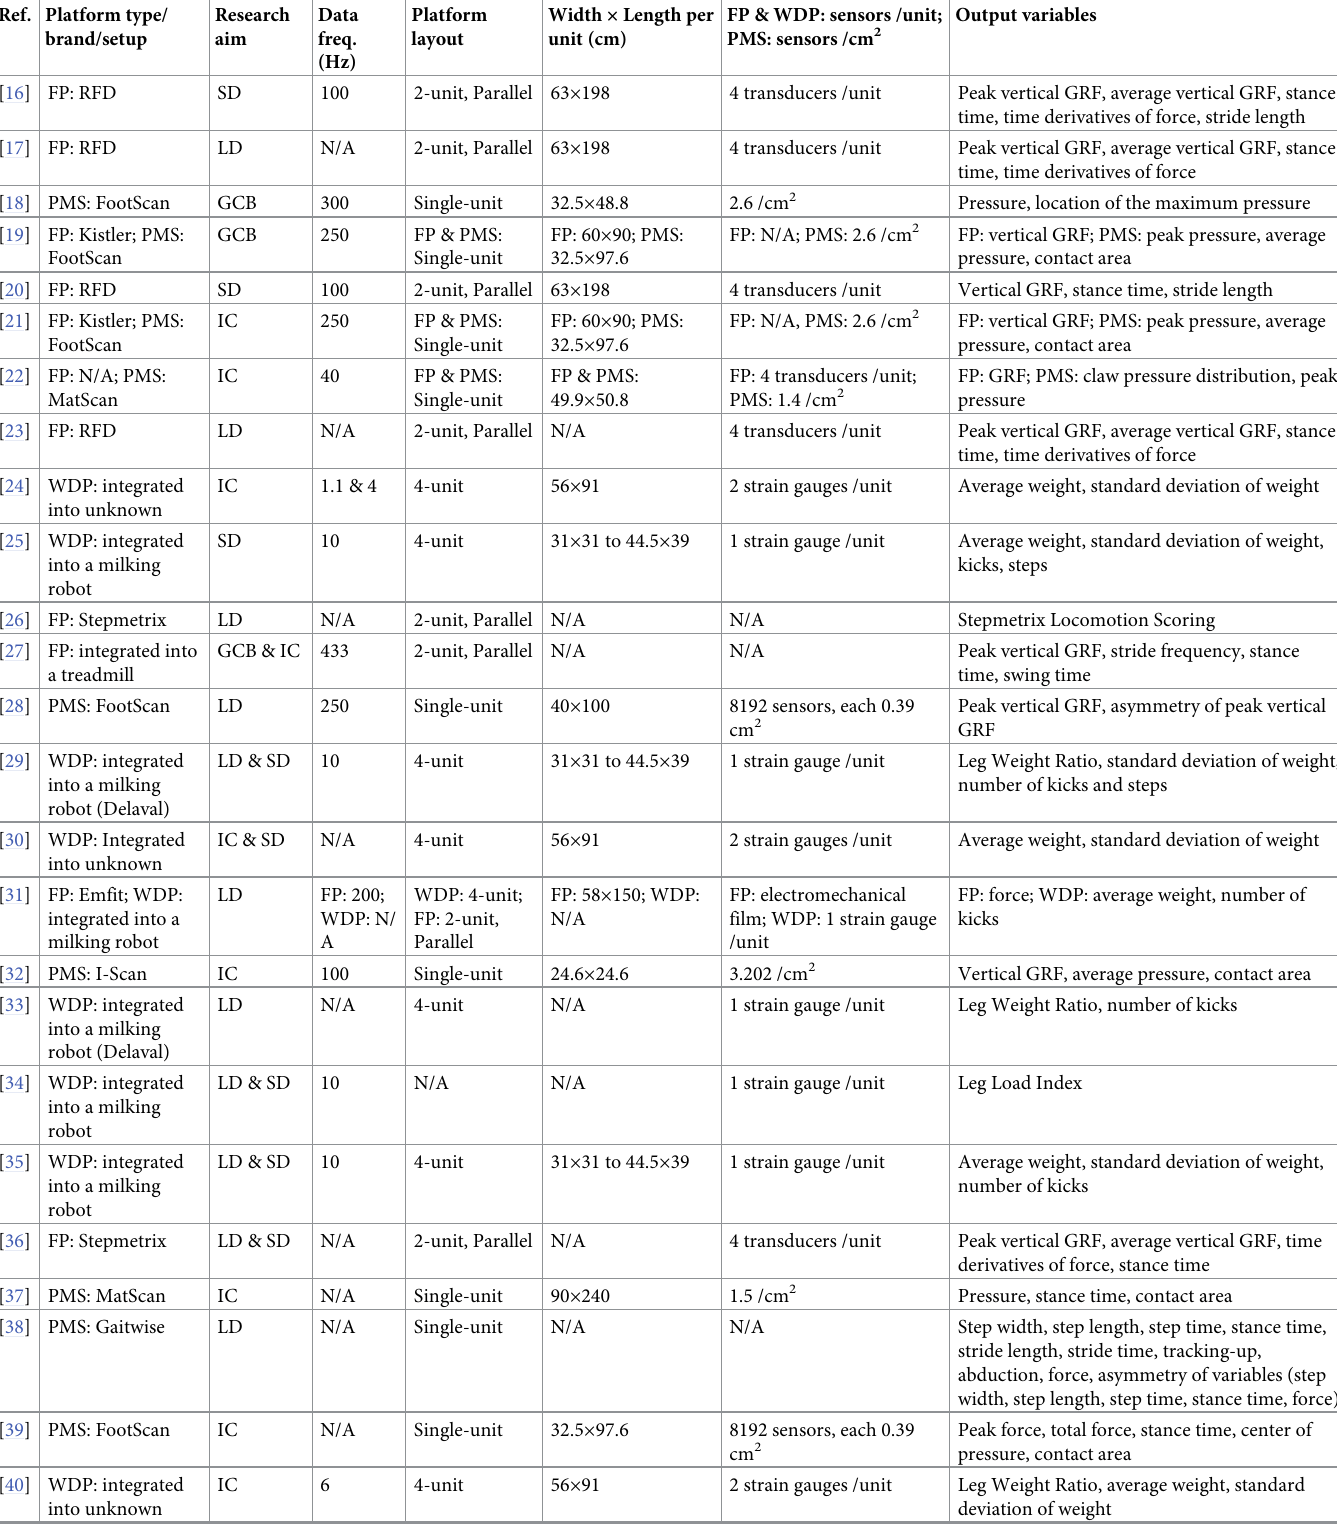
Table 4. Overview of studies included in the review that used force and pressure platforms (FPP). Ref. Platform type/